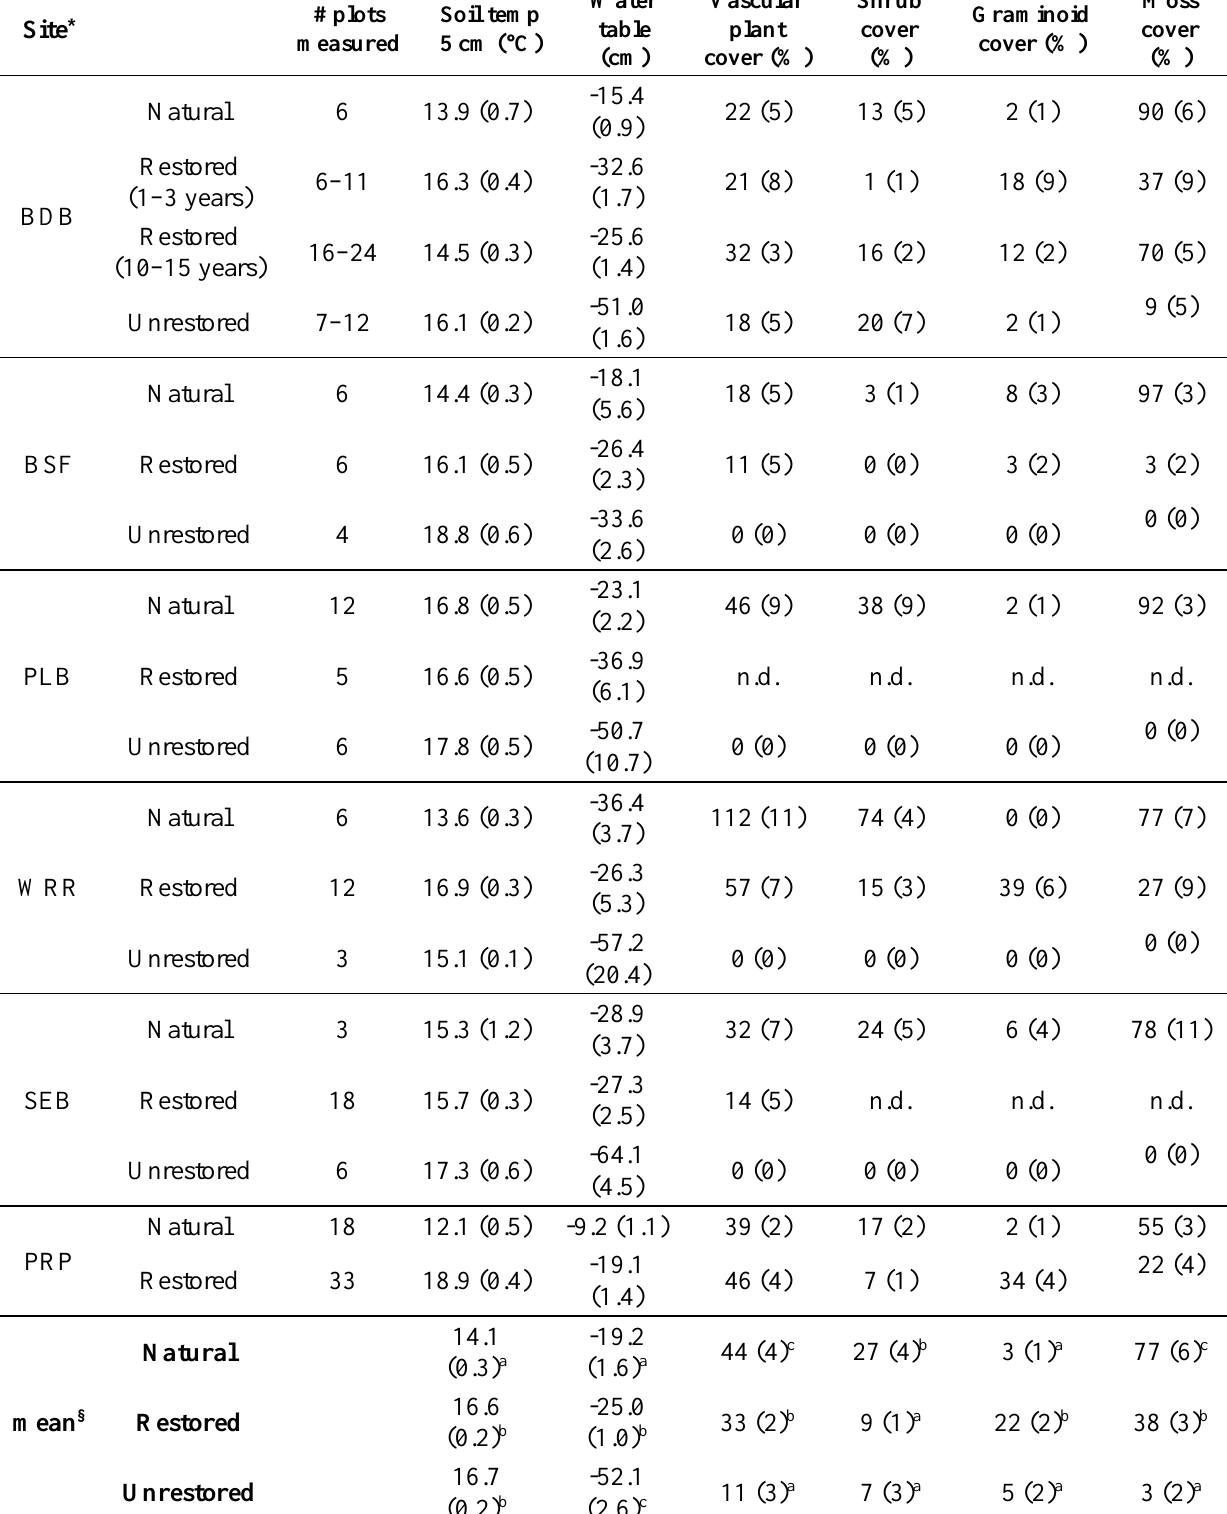
Table 1. Average (standard error) site characteristics. Site *